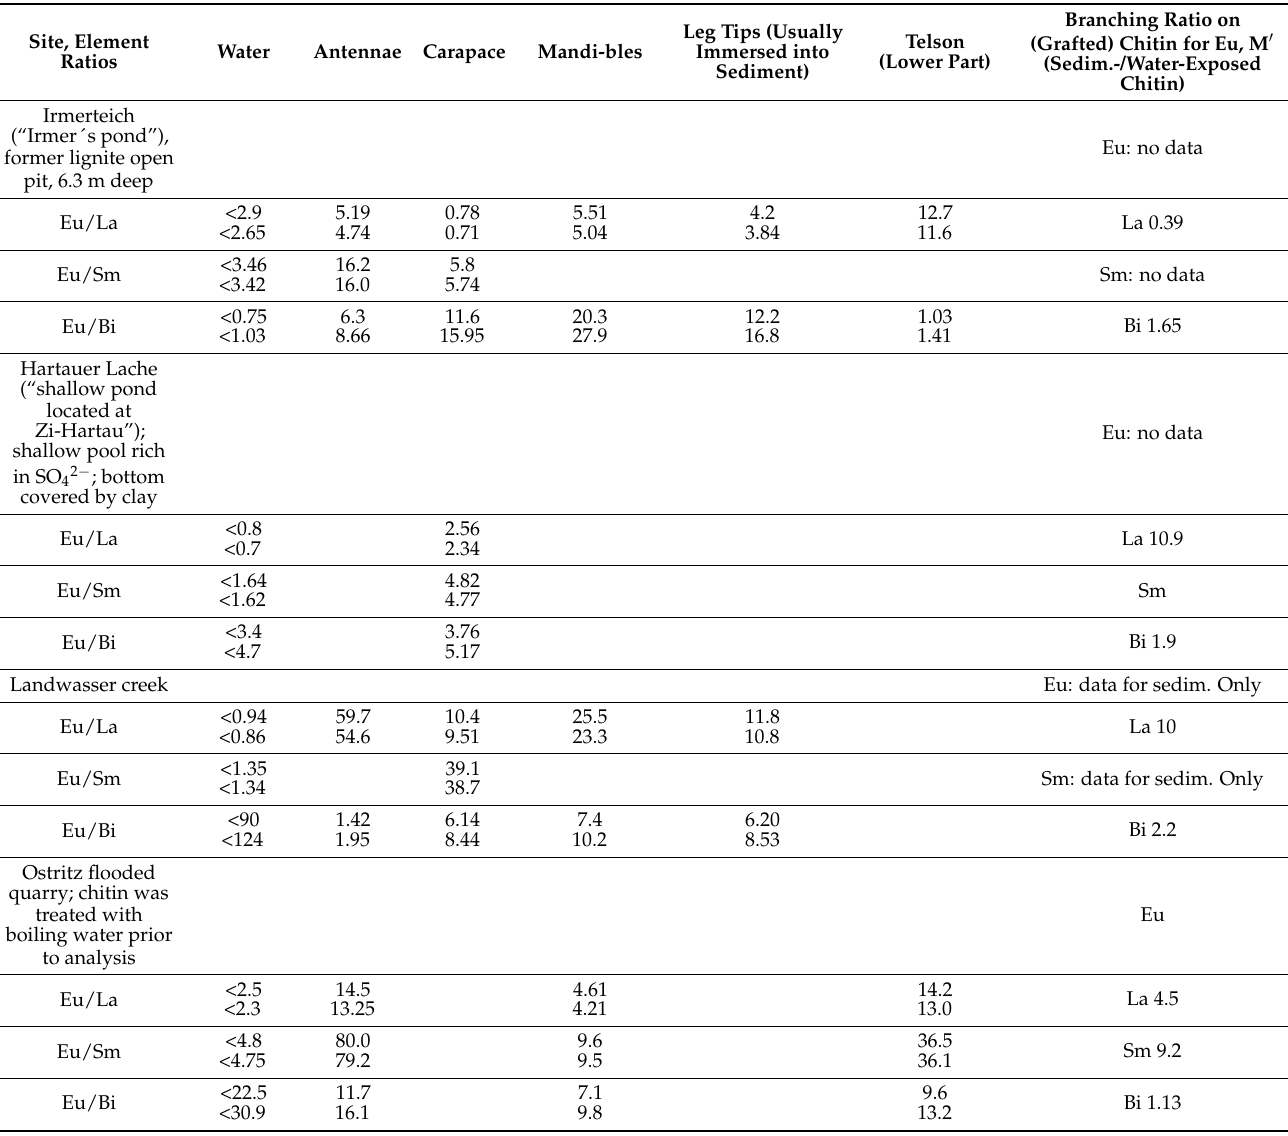
Table 2. Relative metal adsorption by chitin (grafted or in different parts of O. limosus ) in several water bodies in Upper Lusatia (Saxony, FR Germany). Blanks denote missing data (too little for analytical determination), and the upper limits in water are due to all Eu levels in water itself being below determination limit (90 ng/L or ≈ 600 pMol/L, that is, much higher than for other REEs or Bi or